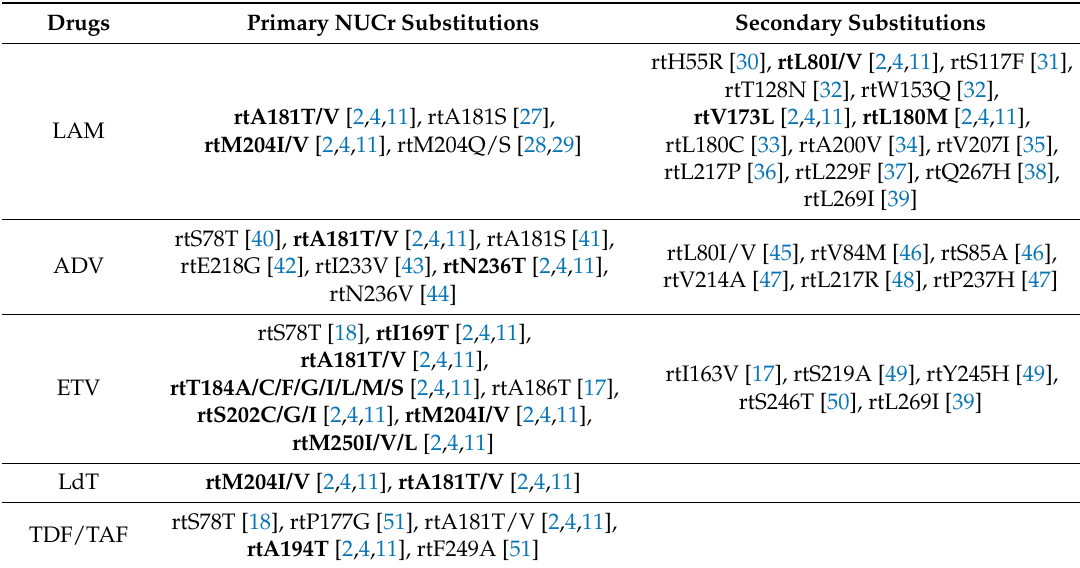
Table 1. Summary of potential AA substitutions associated with NUCr in treated CHB patients. Drugs Primary NUCr Substitutions Secondary Substitutions